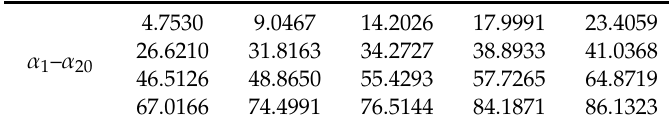
Table 2. Values to bipolar 20 switching-angle case (unit: degree) when V ac 1 = V ac 2 = 0.6 (normalized), k = 37.